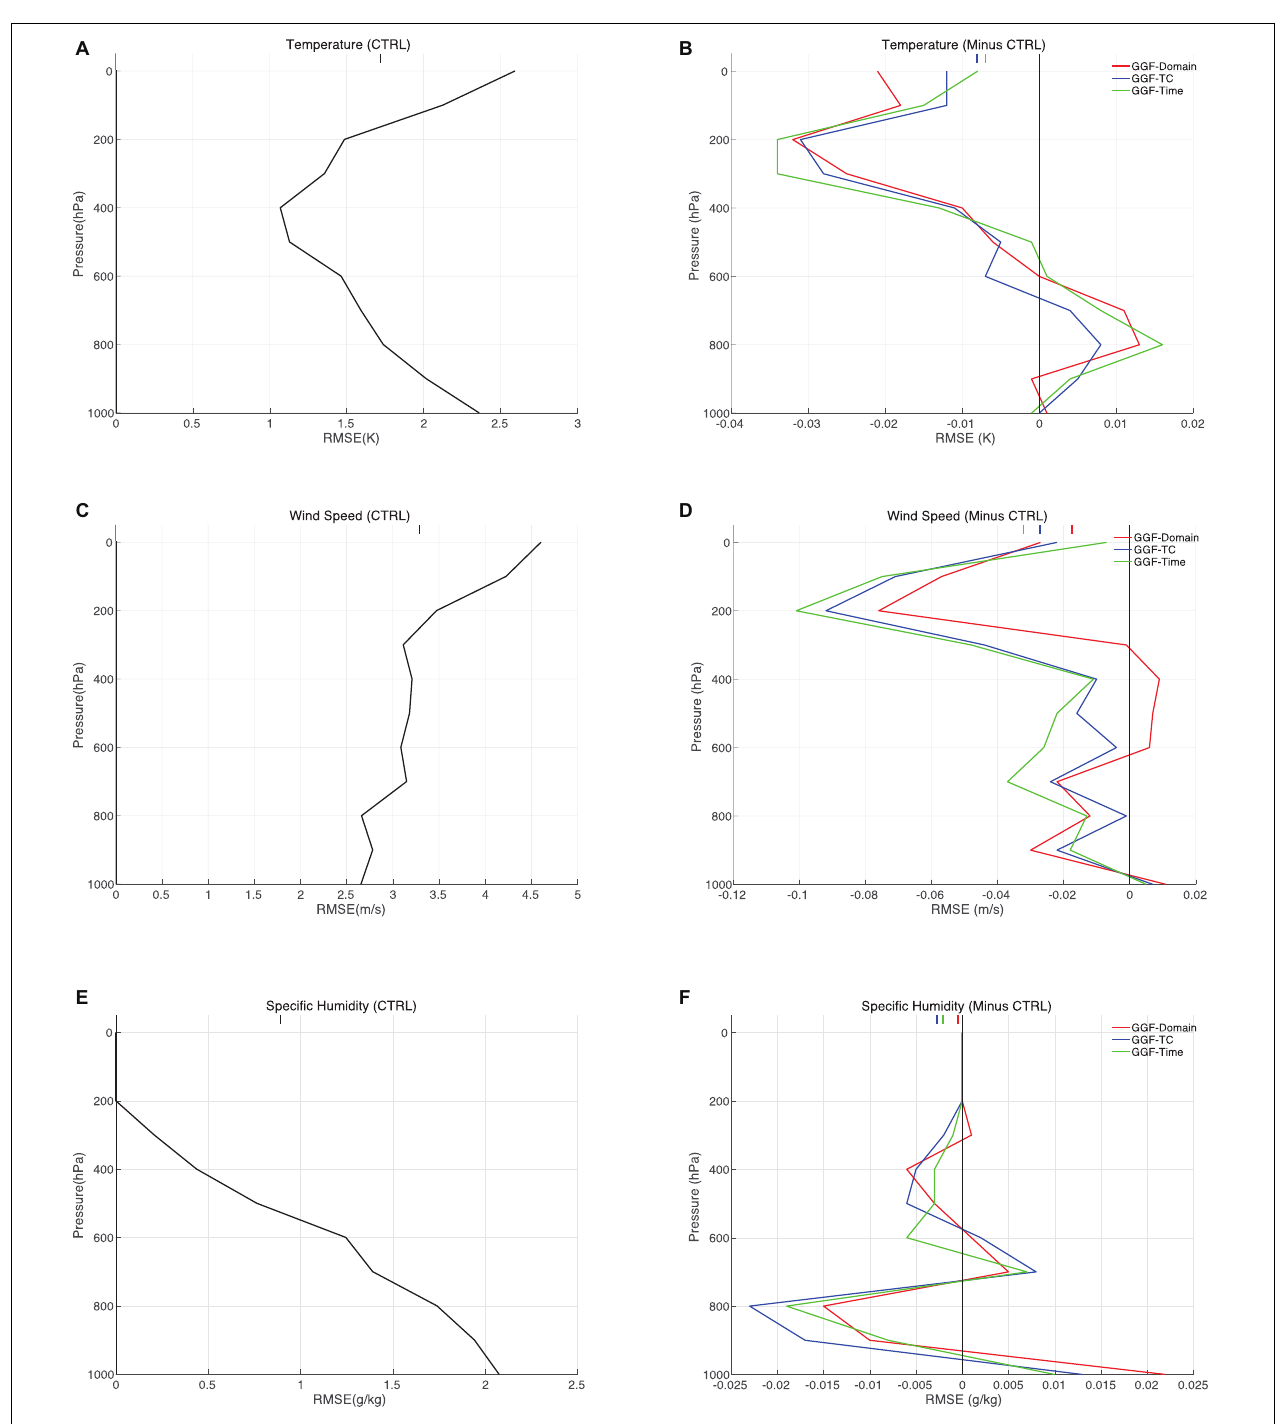
FIGURE 6 | RMSEs of 6-h priors verified relative to (A) temperature, (C) wind speed and (E) specific humidity of experiment CTRL, and error differences between the GGF experiments and experiment CTRL for (B) temperature, (D) wind speed, and (F) specific humidity. The bars on top denote the average values.